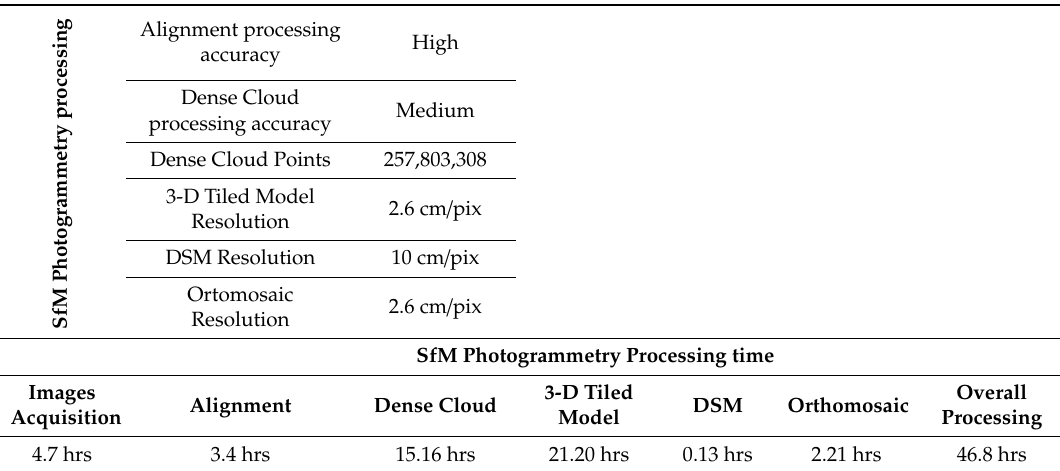
Table 2. Summary of resolution and time processing for DSM, orthomosaic and 3-D tiled models derived using